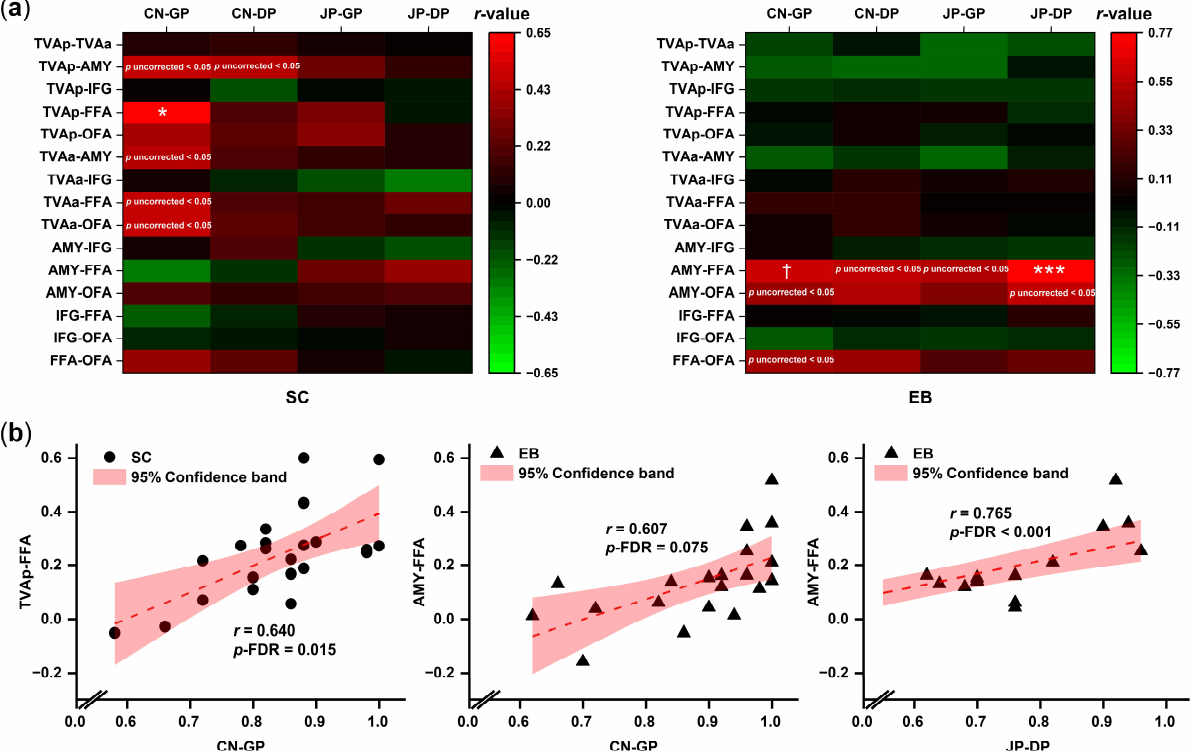
Figure 4. FC-behavior correlations. ( a ) Correlation analyses between the mean FC strength and mean voice-recognition accuracy of the sighted (SC) and blind (EB) participants. Abbreviations: CN-GP, accuracy in the Chinese condition in the Generalization phase; CN-GP, accuracy in the Chinese condition in the Delayed memory phase; JP-GP, accuracy in the Japanese condition in the Generalization phase; JP-GP, accuracy in the Japanese condition in the Delayed memory phase. The color bar represents Pearson’s r . Significance indicated by † ( p -FDR = 0.075), * ( p -FDR < 0.05) and *** ( p -FDR < 0.001). ( b ) Scatterplots show the significant correlations (after FDR corrected) between the ROI-to-ROI FCs and the voice-recognition performance accuracy.